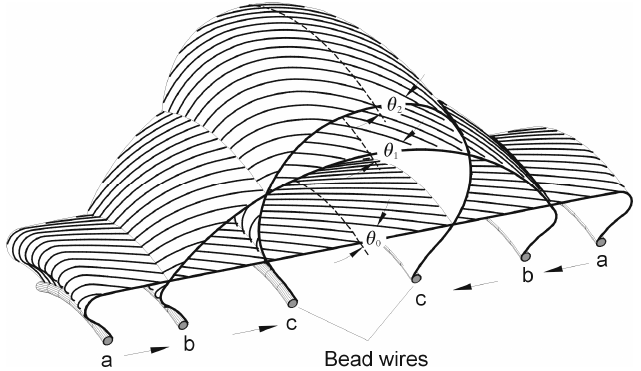
Figure 2. Changes in cords angle and density in a ply during tire forming stages: a – initial on the tire building drum, b – intermediate, c – final ( θ 2 < θ 1 < θ 0 ).